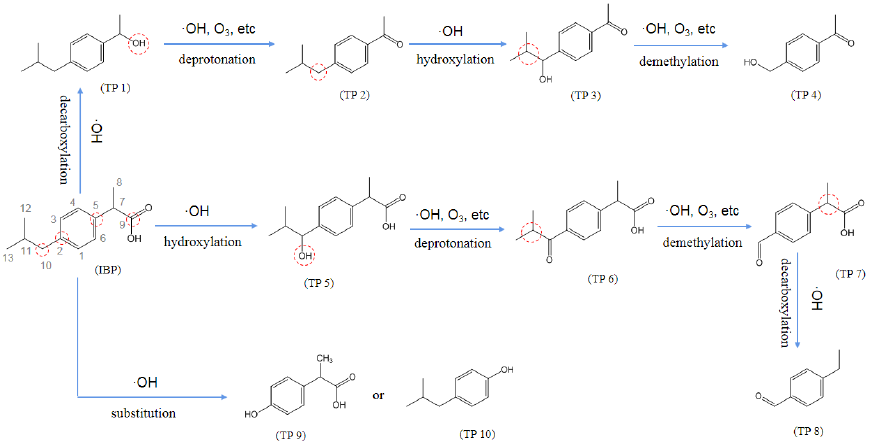
Figure 4. The proposed IBP degradation pathway.